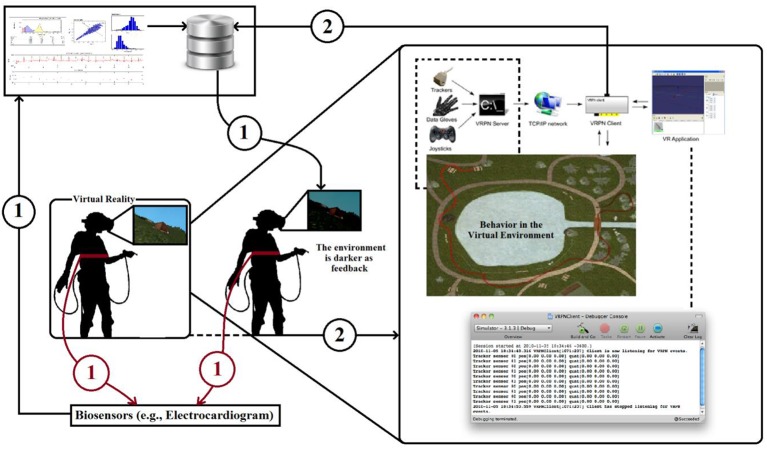
Loop (1) represents the classic biofeedback where the environmental light changes continuously on the basis of physiological parameters. Loop (2) represents an extended version in which the individual's behavior contributes to the changes in the virtual environment. Loop (2) may also include information from other individuals (group biofeedback). Eventually, these individuals may have relationships (networked biofeedback).